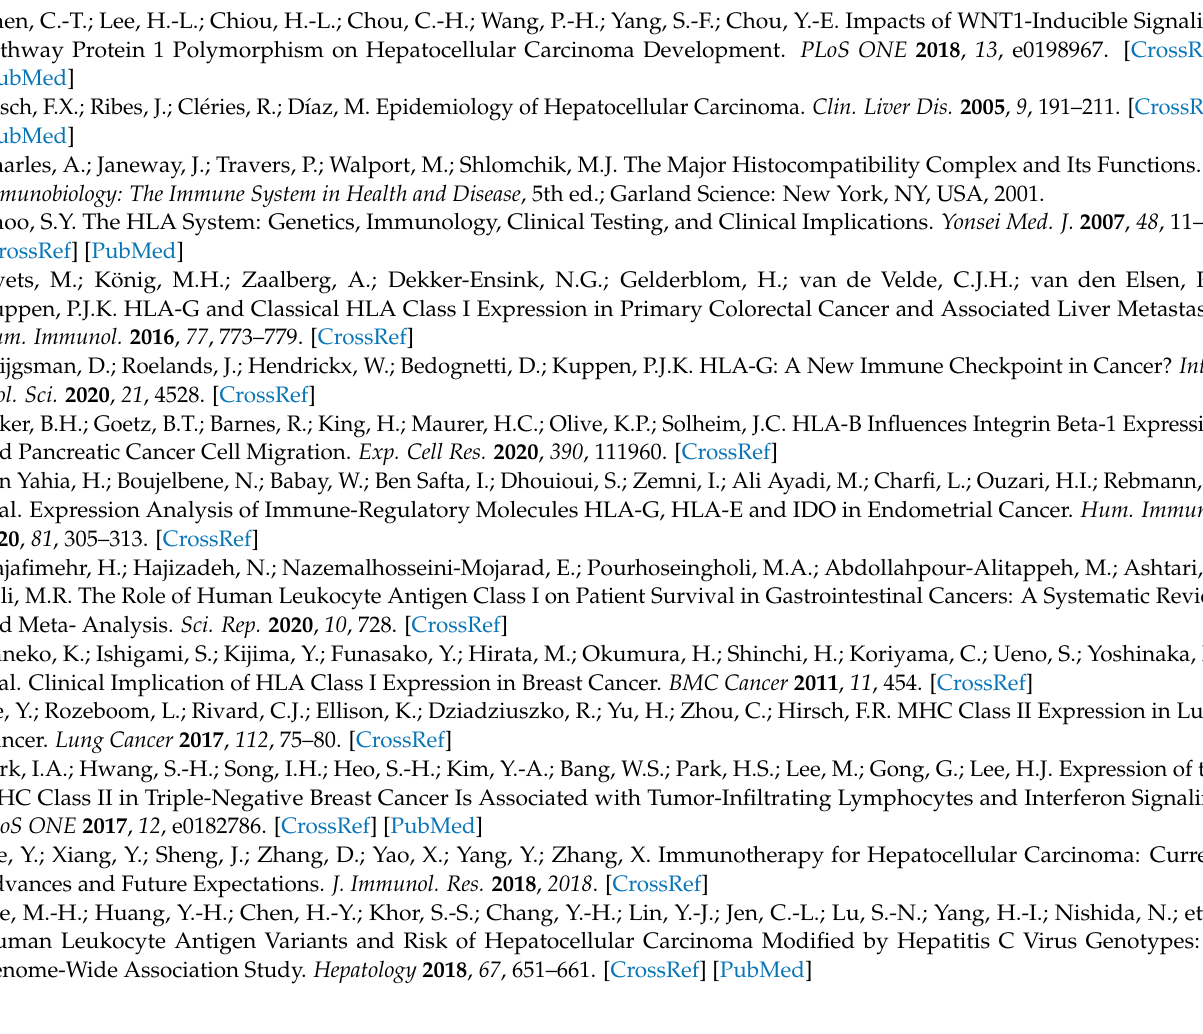
Table S2: Clinicopathological characteristics of Validation cohort (372 HCC patients), Table S3: Asso- ciation of expression of HLA genes with clinical features in Discovery cohort, Table S4: Association of expression of HLA genes with clinical features in Validation cohort, Table S5: MHC gene and their correlated gene list, Table S6: Gene name and chromosomal location of 40 unique